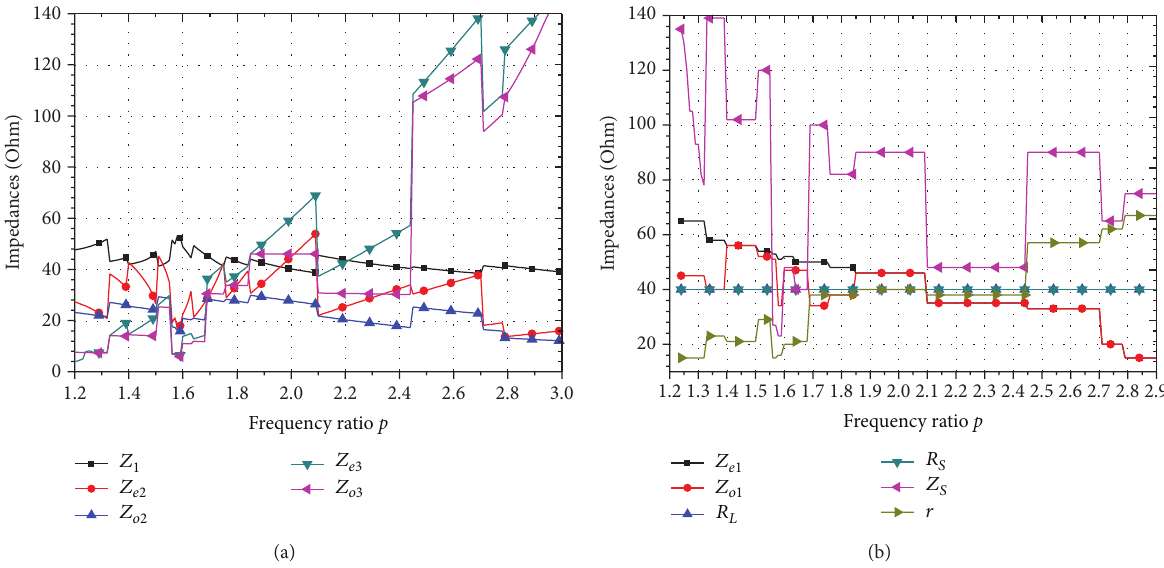
Figure 3: Typical design parameters of the proposed dual-band power divider with 𝑅 𝐿 = 𝑅 𝑆 = 40Ω . (a) Values of 5 variables: 𝑍 1 , 𝑍 𝑒2 , 𝑍 𝑜2 , 𝑍 𝑍 𝑒3 , and 𝑜3 . (b) Values of 6 free variables: